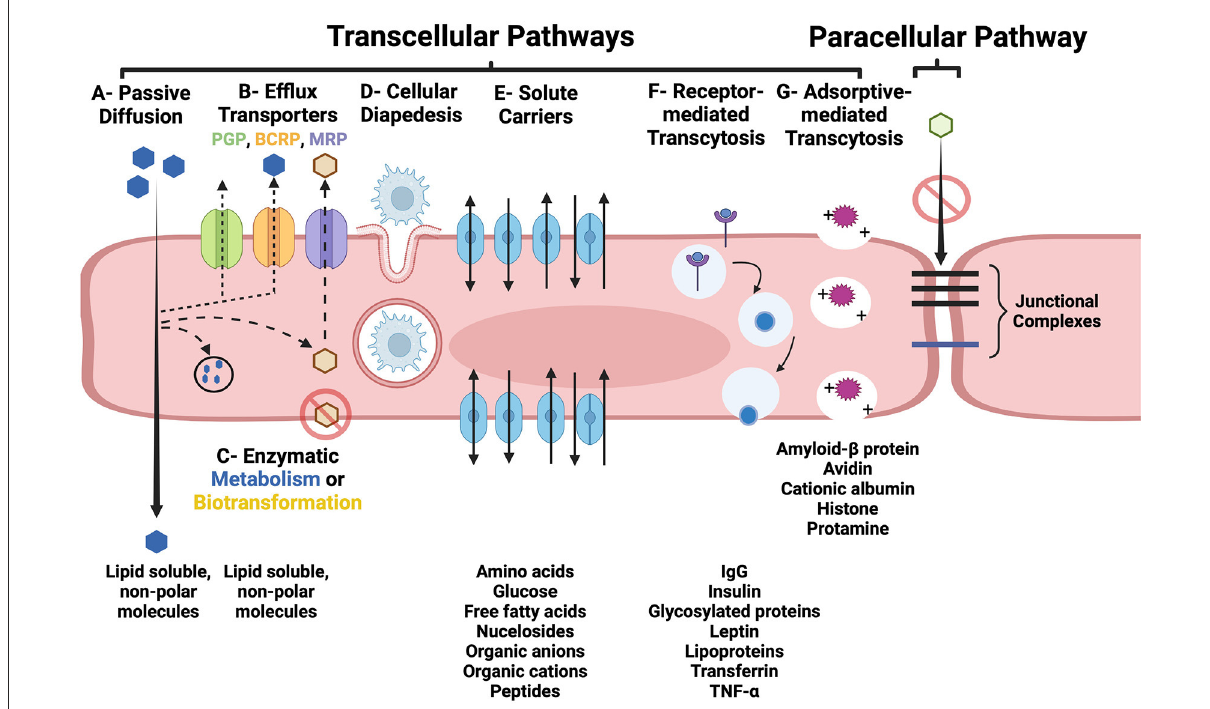
FIGURE2 Transcellular (A–G) and paracellular pathways of transport across the BBB. (A) Lipid soluble, non-polar substances may passively diffuse through BEC. (B) Parent compounds and metabolites can also be subjected to removal from the BEC by active efflux transporters, such as PGP, BCRP, and MRP. (C) Lipid soluble molecules may be subjected to enzymatic metabolism or biotransformation which can prevent them from traversing the BEC and entering the interstitial fluid of the brain or facilitate their removal via efflux pumps. (D) Diapedesis of leukocytes through and intact BEC. (E) Carrier-mediated transport of many essential polar molecules and nutrients into the brain occurs via numerous specific solute carrier system. Receptor- (RMT; F ) and adsorptive-mediated transcytosis (AMT; G ) use vesicular based transport systems to move macromolecules across the BBB. RMT is initiated following ligand binding to a membrane receptor, and AMT is induced by interaction of positively charged macromolecules with the luminal BEC membrane. In the intact BBB, junctional complexes, including tight and adherens junctions, prohibit the paracellular transport of substances. Figure created with